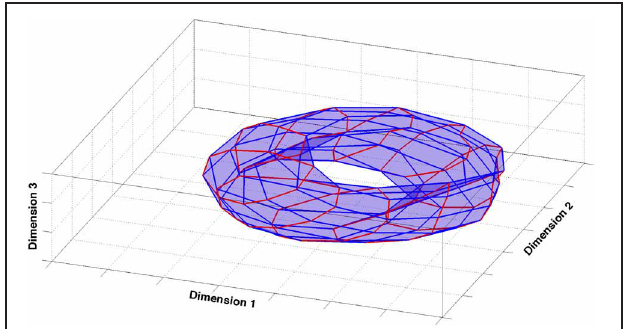
FIGURE 1 | Multidimensional scaling analysis. The figure shows the 3-dimensional configuration of template vectors based on pairwise correlations obtained by multidimensional scaling [Sammon criterion (Sammon, 1969)], applied to the spatial representation produced by the model CA3 network. The configuration closely reproduces the original similarity matrix (Stress = 0.04). Red and blue lines correspond to orthogonal directions in the external